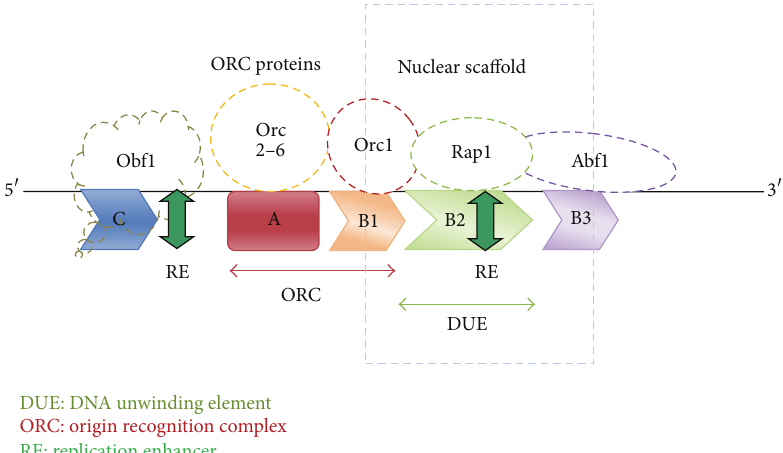
Figure 11: Location of SAR and RE sequences at the S. cerevisiae ARS. Three domains of the S. cerevisiae ARS, that is, A, B, and C, are shown. Also the approximate locations of the nuclear scaffold attachment regions and replication enhancer sequences based on our analysis are shown. Different types of proteins that bind to different domains of ARS are also shown in the figure.